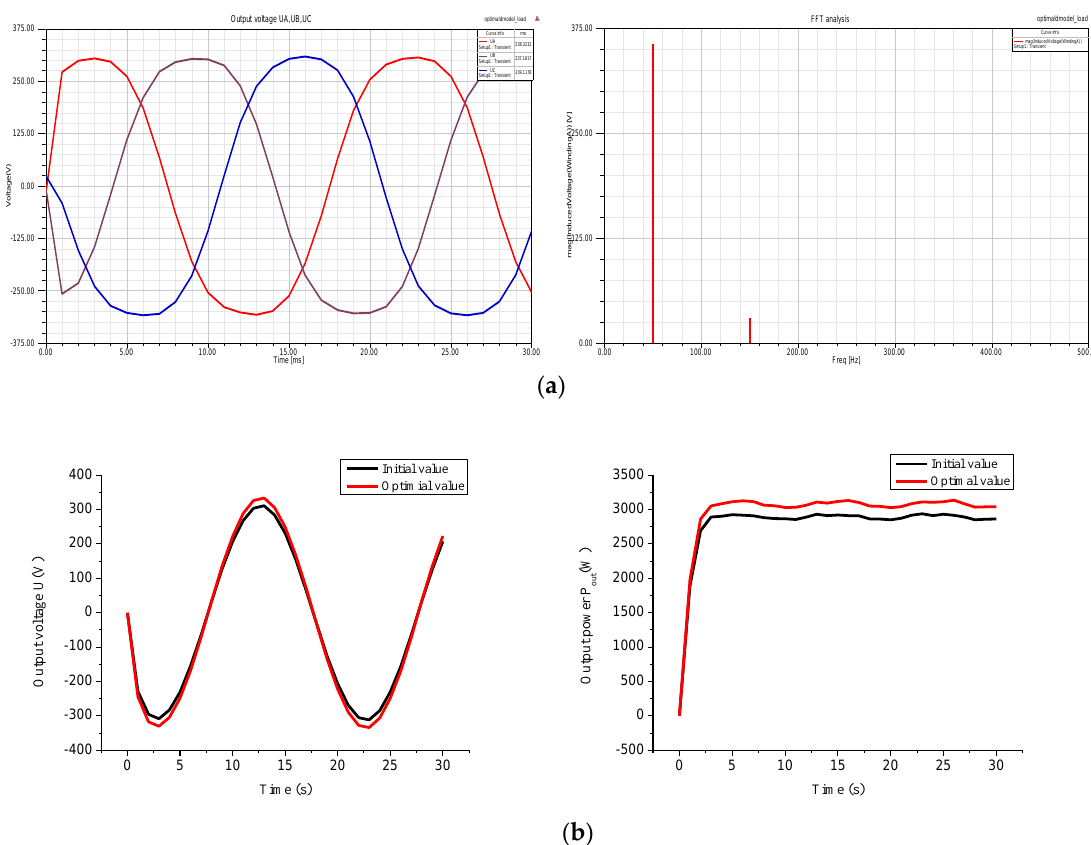
Figure 16. Distribution and comparison of output performance: ( a ) Output voltage after optimization and Fast Fourier Transform (FFT) analysis; ( b ) Output voltage and power comparison before and after optimization.